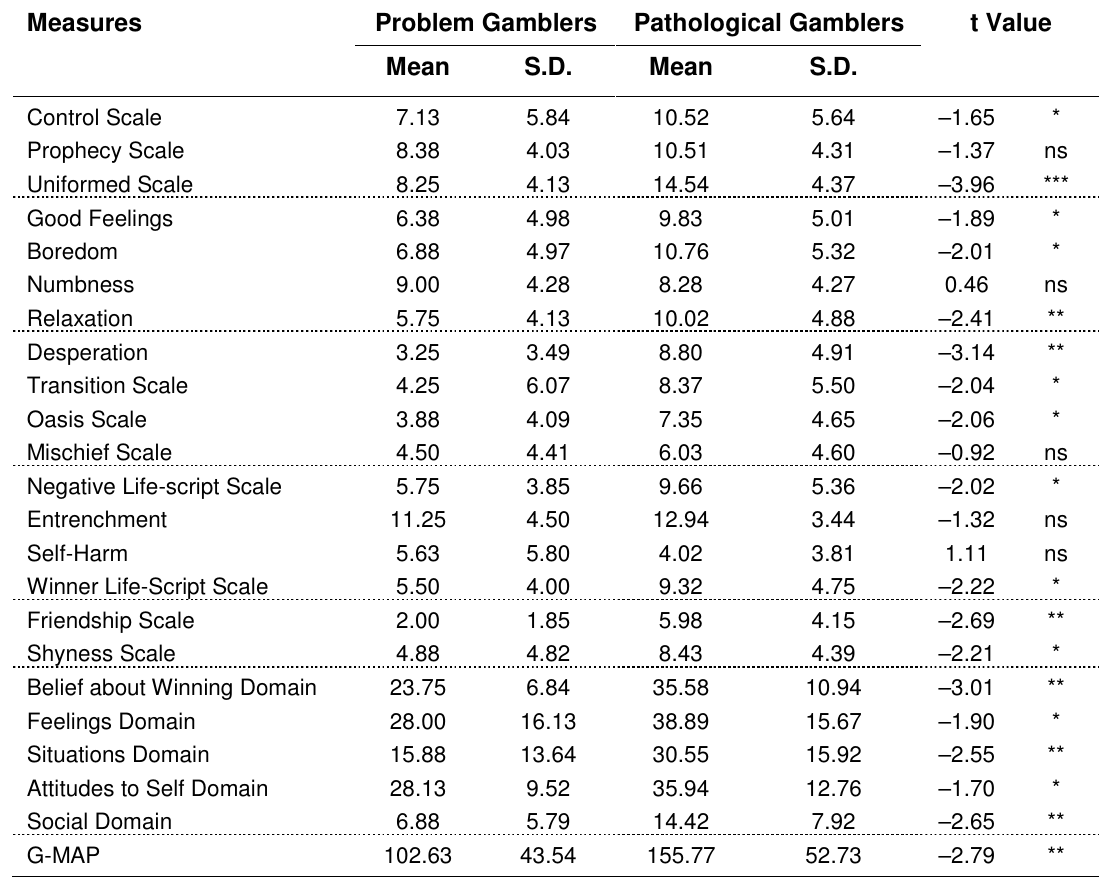
Differences Between Problem Gamblers and Pathological Gamblers on the G-MAP Measures Problem